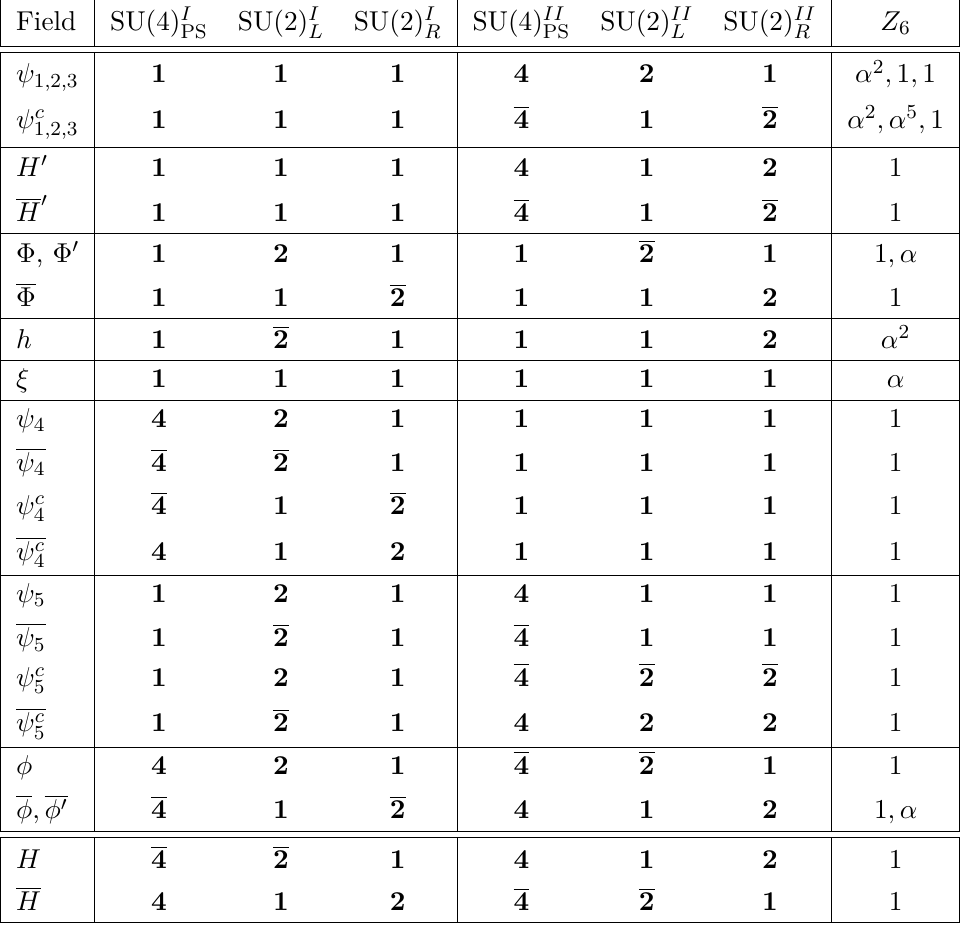
. The model consists of three left-handed Table 1 . The twin PS theory based on G I × G II 422 422 chiral fermion families ψ under the second PS group, plus a VL fourth and fifth fermion c 1 , 2 , 3 , ψ 1 , 2 , 3 family ψ and their conjugates. The symmetry is broken by the scalars H 0 , Φ , etc. Two Higgs c 4 , 5 , ψ 4 , 5 doublets are contained in h . Additional personal Higgs doublets are contained in H, H . A Z symmetry is broken by the Majoron scalar ξ